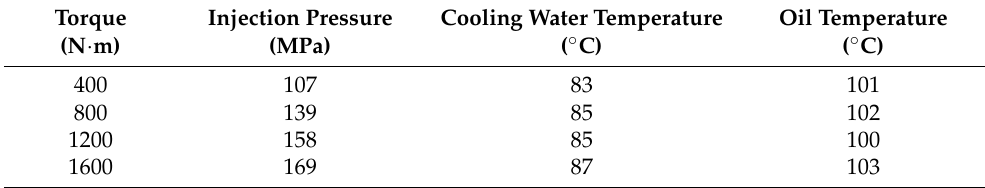
Table 7. Other conditions in